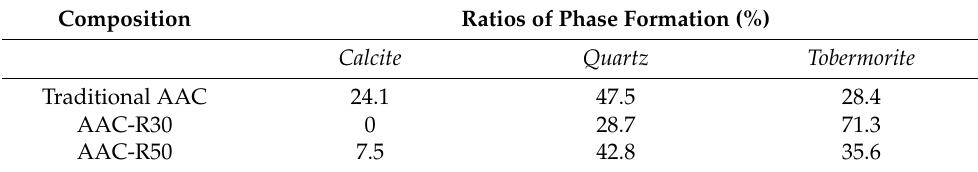
Table 2. Ratios of recycled AAC phase